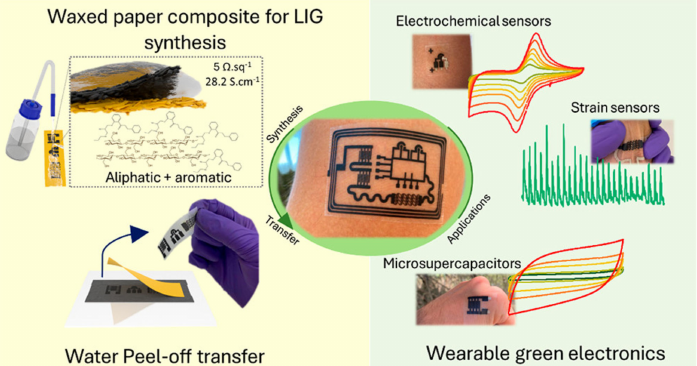
Figure 2. Electronically enhanced paper-based green wearable system. Reproduced with permission from [11]. Copyright 2022 American Chemical